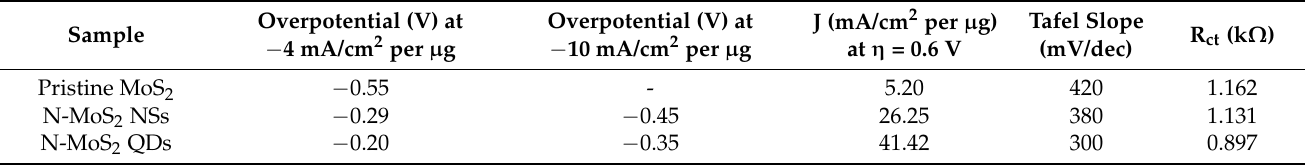
Table 2. Electrochemical characteristics of pristine MoS 2 , N-MoS 2 NSs and QDs